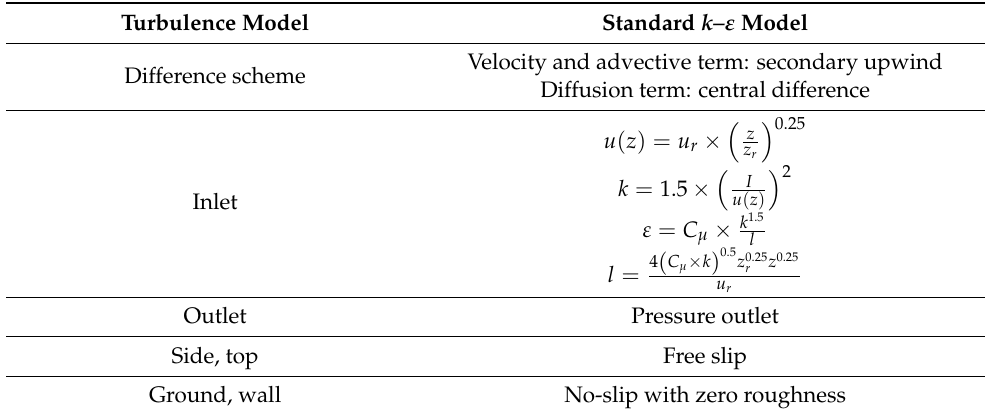
Figure 7. Calculation domain. Table 4. Calculation